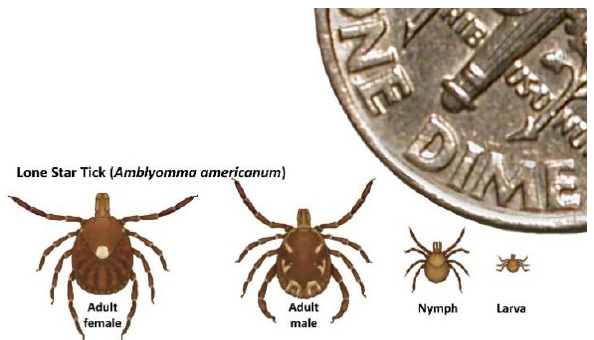
Figure 3. Life stages of Amblyomma americanum . A. americanum is implicated as a probable vector of HRTV in North America based on repeated field isolations, vector competence, and catholic host-feeding behavior. White-tailed deer serve as hosts for all three A. americanum [36] life stages, but all stages can feed on humans. Adults feed principally on middle-to-large-sized mammals, while larvae and nymphs typically feed on ground-associated birds, middle-sized mammals, and occasionally, on small mammalian hosts.